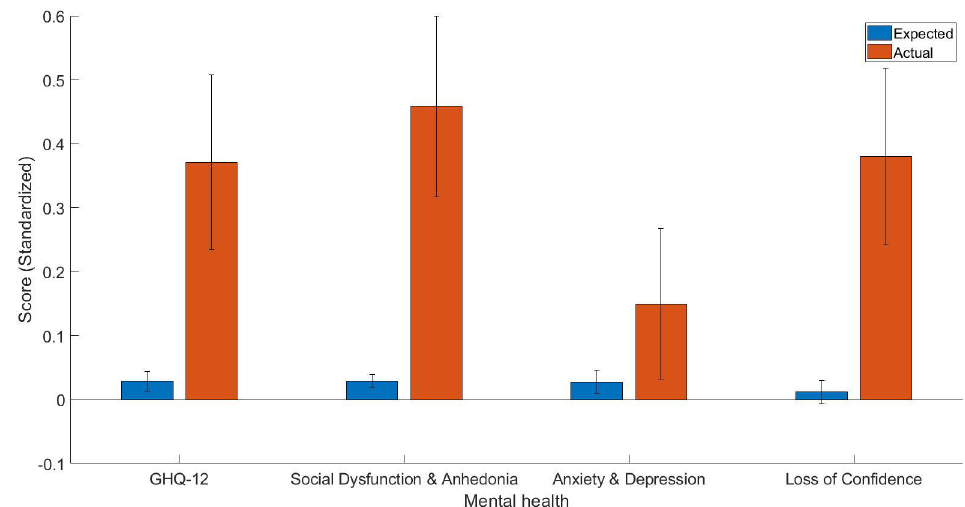
Figure 1. The expected and actual scores of general and dimensions of mental health (standardized).